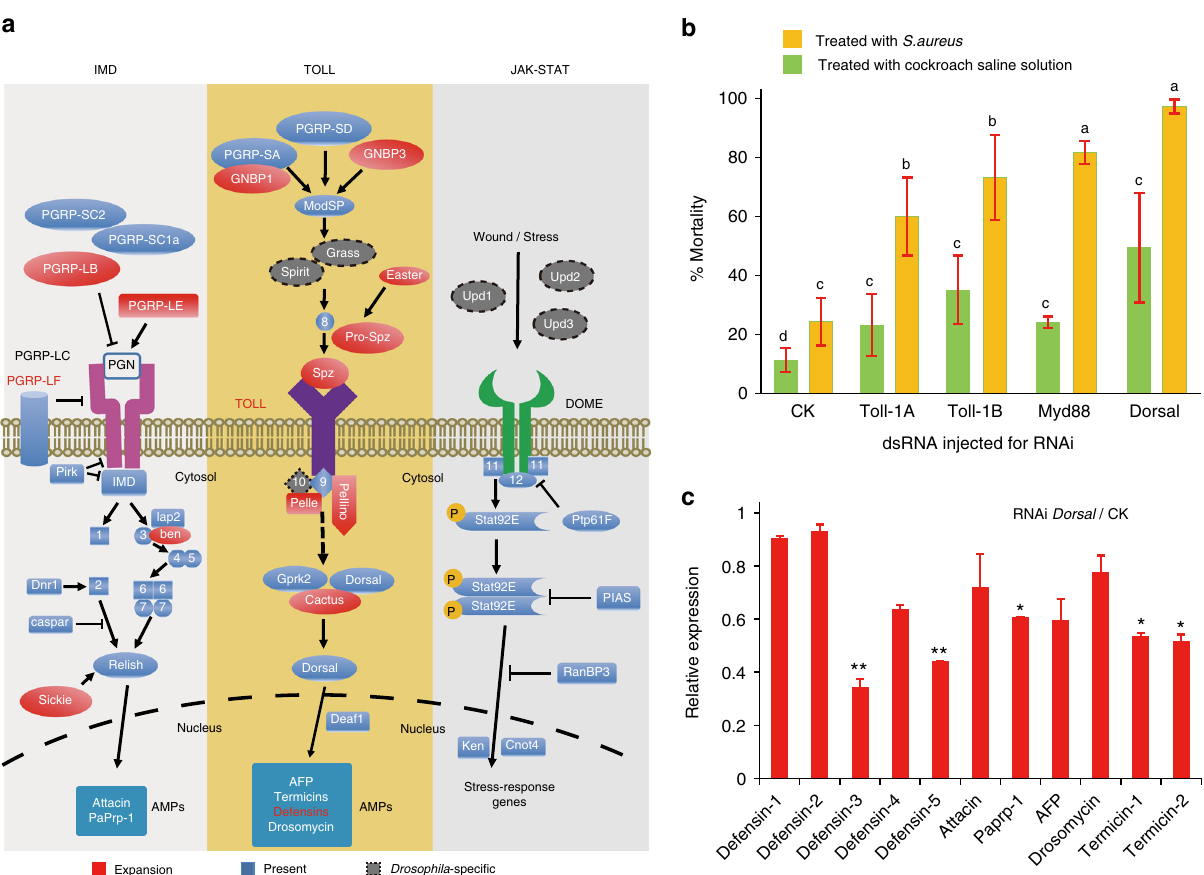
Fig. 3 Gene repertoire of the innate immune system and functional analyses of the Toll pathway in P. americana . a Representation of three main innate immune signaling pathways (Imd, Toll, and JAK-STAT, proposed in Drosophila ) 22 – 24 in P. americana . Genes from expanded gene families in P . americana are highlighted in red. Since all genes absent in P . americana were also found to be absent in other insect species, they were de fi ned as Drosophila -speci fi c components and outlined by gray dashed lines. 1, fas-associated DD protein; 2, death-related Ced-3/Nedd2-like protein; 3, effete; 4, TAK1-binding protein 2; 5, TGF- β -activated kinase 1; 6, kenny; 7, immune response de fi cient 5; 8, spätzle-processing enzyme; 9, myeloid differentiation primary response 88; 10, tube; 11, hopscotch; 12, socs36E; AMP, antimicrobial peptide; DOME, domeless; Dnr1, defense repressor 1; GNBP, Gram-negative binding protein; Gprk2, G protein-coupled receptor kinase 2; Grass, Gram-positive-speci fi c serine protease; Iap2, inhibitor of apoptosis 2; IMD, immune de fi ciency; ModSP, modular serine protease; PGN, peptidoglycan; PGRP, peptidoglycan recognition protein; Pirk, poor IMD response upon knock in; Spz, spätzle; Spirit, serine protease immune response integrator; Stat92E, signal transducer and activator of transcription protein at 92E. Detailed information is additionally shown in Supplementary Tables 11 – 15. b Functional veri fi cation of genes in the Toll pathway against a classic Gram-positive bacterium, Staphylococcus aureus . Four major genes in the Toll pathway were knocked down by RNAi, compared to injection of control dsRNA (CK, a 92 bp non-coding sequence from the pSTBlue-1 vector). Corresponding mortality is shown upon S. aureus infection. Injection of cockroach saline solution (CSS, as a control) or S. aureus was performed 24 h after dsRNA injection. Error bars indicate standard deviation of three replicates. Bars labeled with different lowercase letters indicate signi fi cant difference between the two samples, with p < 0.05, one-way analysis of variance (ANOVA). c Functional relationship between the Toll pathway and expression of AMPs. Dorsal , a key component in the Toll pathway whose depletion caused the greatest mortality (shown in b ), was knocked down by RNAi. Correspondingly, the relative expression of 11 antimicrobial peptide genes were measured and shown in c . Error bars represent s.d. of three replicates. Two-tailed Student's t-test: *p < 0.05; **p <